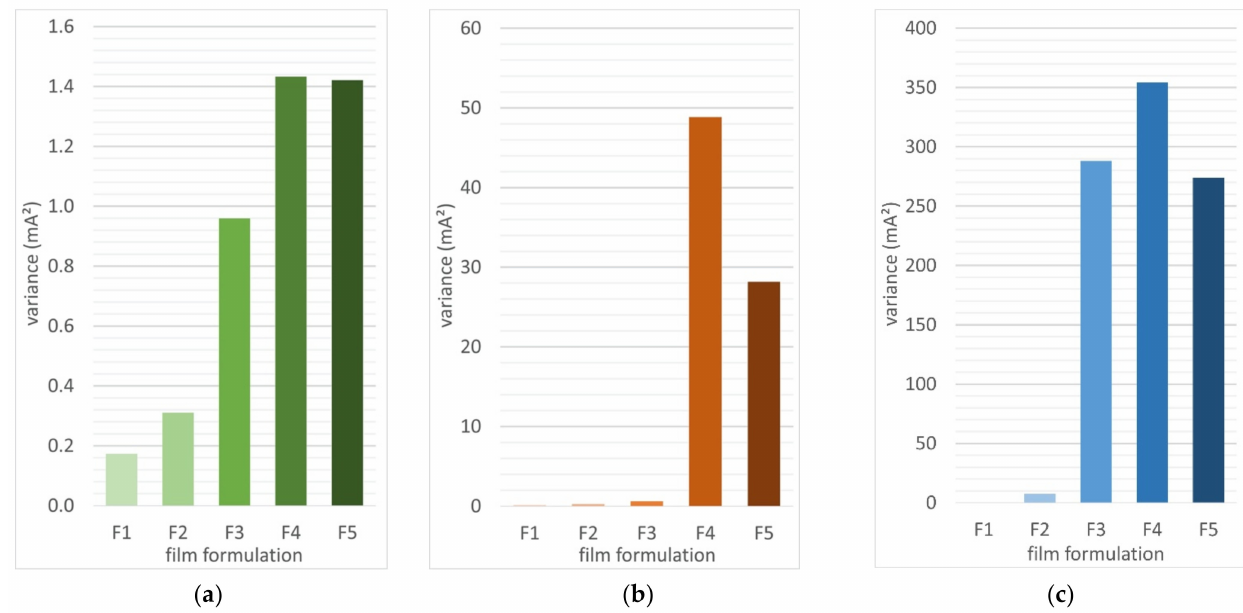
Figure 2. Variance within the UV absorbance of three different plant-based extracts at peak maximum. Ninefold deter- mination (three films with three measurements conducted at random locations of each film). mA: milli absorbance units. ( a ): Thymus vulgaris (TV) extract; peak maximum at λ = 283 nm; ( b ): Aesculus hippocastanum (AEH) extract; peak maximum at λ = 274 nm; ( c ): Abies nordmanniana (AN) extract; peak maximum at λ = 275 nm.